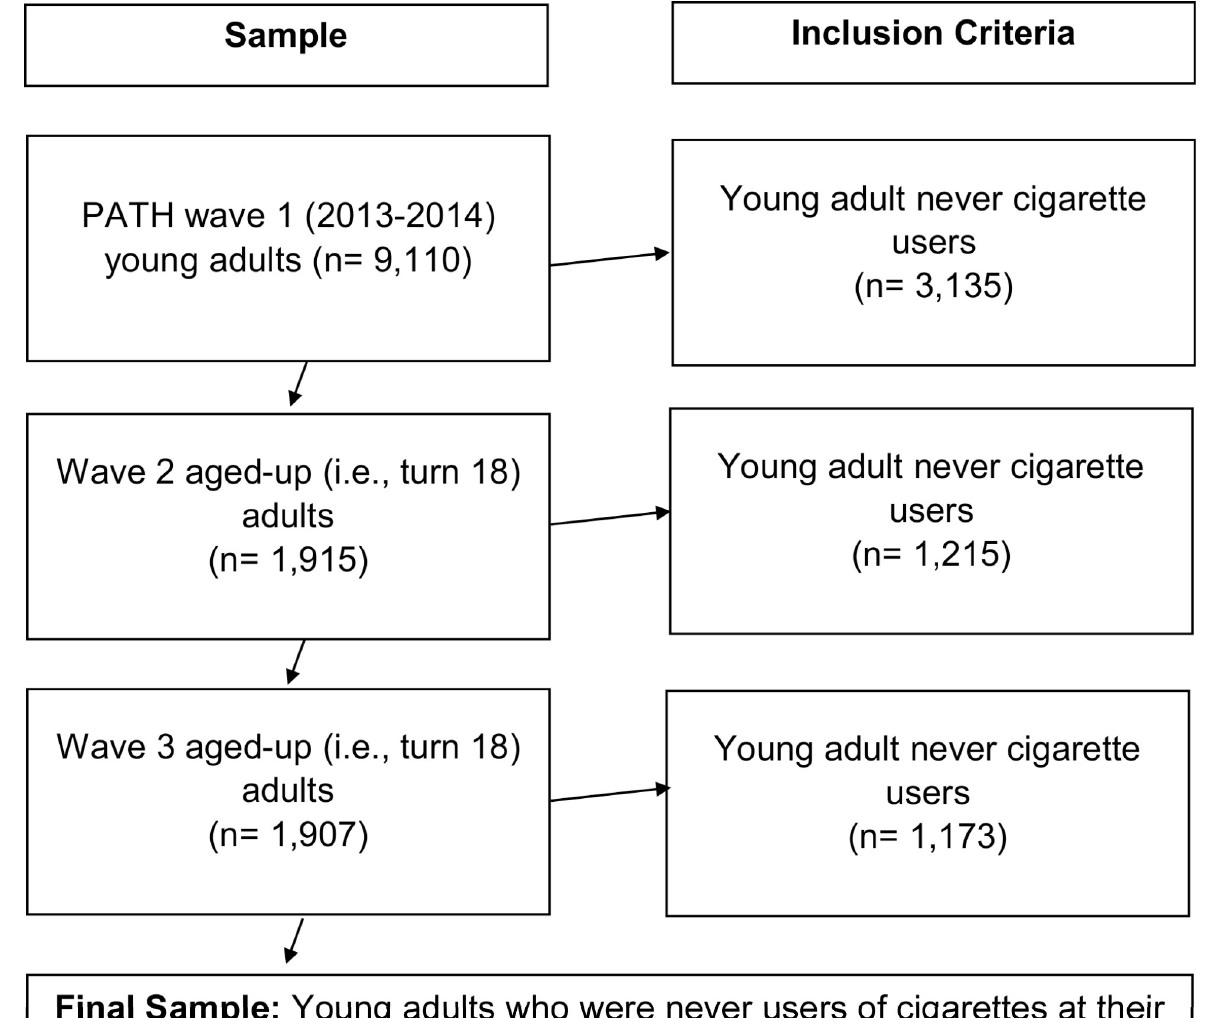
Fig 1. Data management and participant